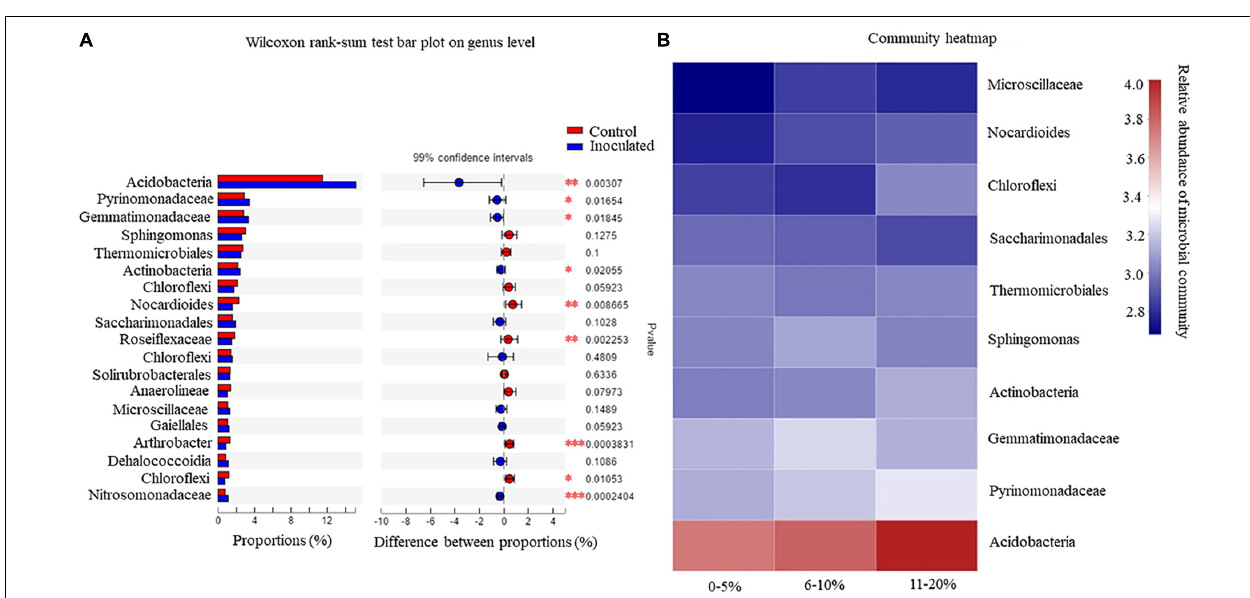
difenoconazole (IE), and control + no difenoconazole (NL). The percentage of community abundance of Proteobacteria was almost similar in control + 1.5% dose of difenoconazole (NG), T. controversa + 3% dose of difenoconazole (IB),